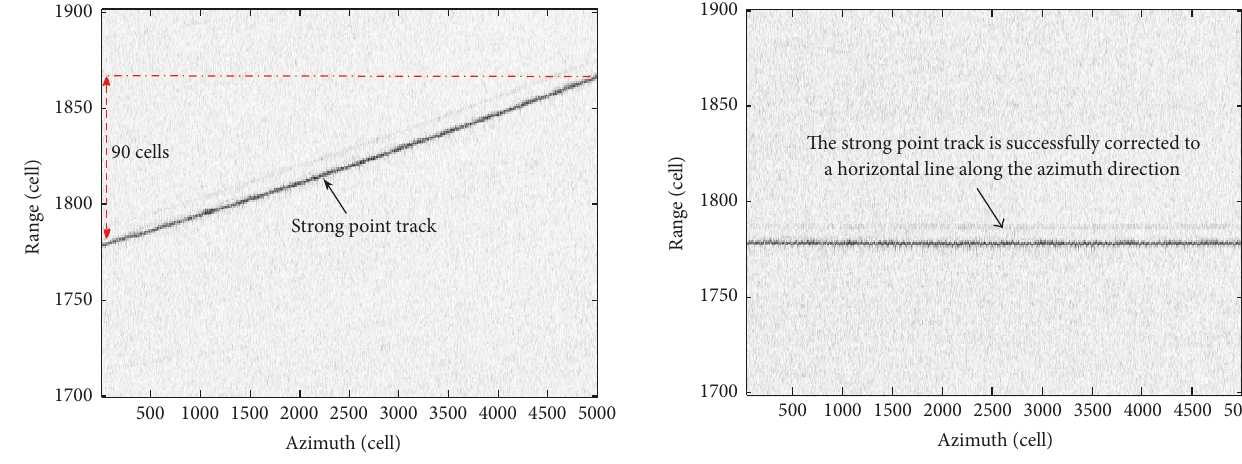
Figure 4: Track of a strong point in the range-compressed echo (monostatic SAR). The RCM of 90 cells is very serious.